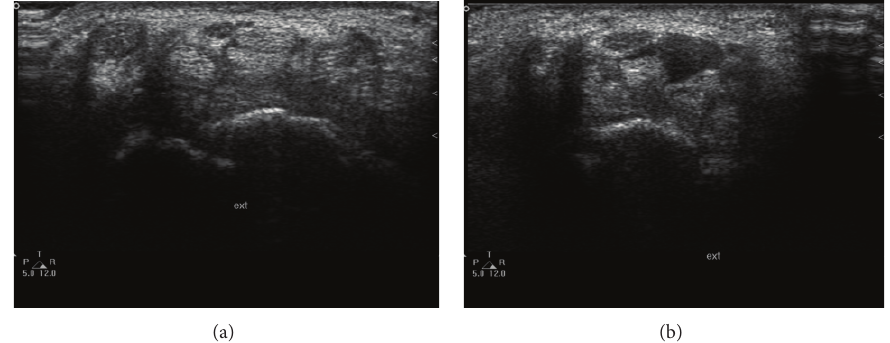
Figure 2: Presence of flexor muscles at the entrance of the carpal tunnel. Median nerve and flexor tendons without muscles (a), Median nerve and flexor tendons with muscles (b).